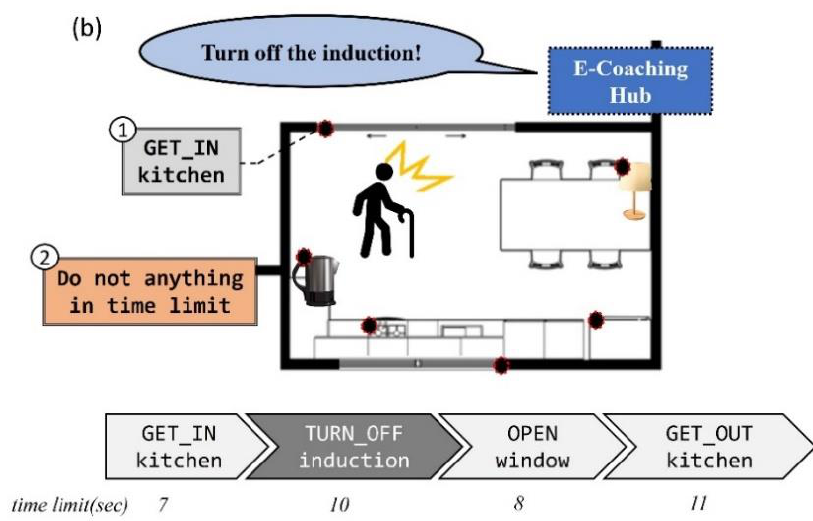
Figure 3. ( a ) Coaching situation caused by an abnormal behavior done in step 3. ( b ) Coaching situation caused by not doing any behavior within the time limit in step 2.